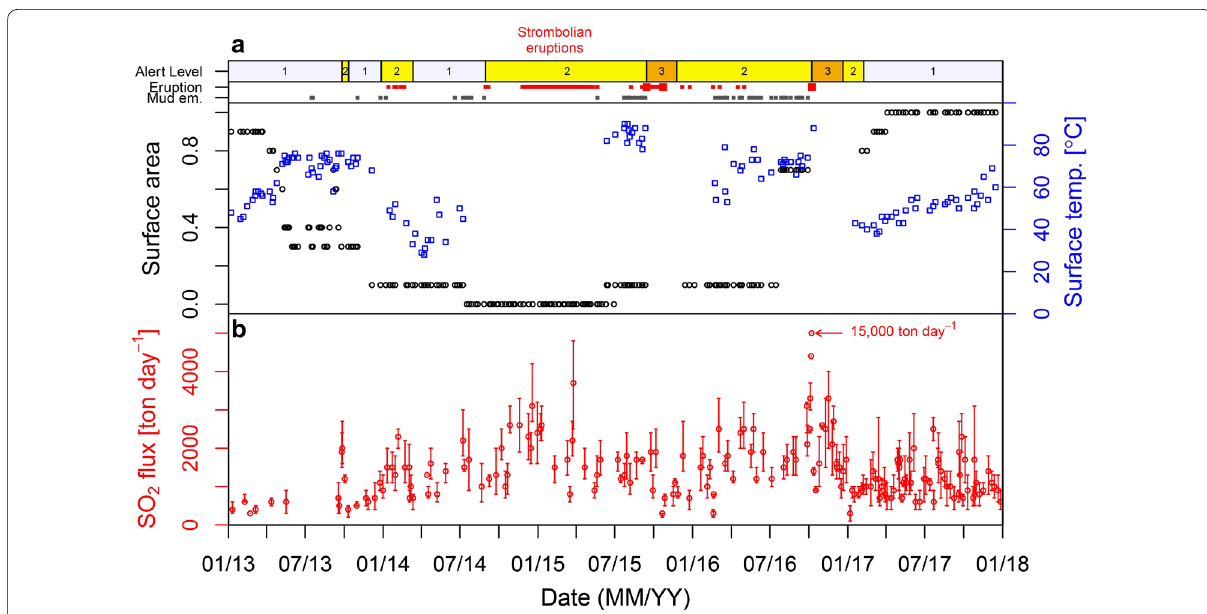
Fig. 2 Time series of a the surface area (black circle) and surface temperature (blue square) of the crater lake and b plume SO 2 flux. The surface area of the crater lake is indicated by the ratio of the area to the crater bottom. The value of 0 in the surface area corresponds to the situation where the crater lake does not exist. The value of 0.1 in the surface area includes the situation where although the crater lake exists, the amount of water cannot be estimated because the crater is mostly covered by the volcanic plume. At the upper part of a , volcanic alert levels issued by the Japan Meteorological Agency (JMA) are presented with a corresponding color code, and the dates of occurrence of eruptions and quite minor mud emissions from the crater bottom are depicted with red and gray dots, respectively. The enlarged dots of eruptions correspond to the phreatomagmatic eruptions on 14 September 2015, 23 October 2015, and 8 October 2016. The text “Strombolian eruptions” corresponds to the period when magmatic eruptions were observed (i.e., intermittent ash emissions and Strombolian eruptions). The data are from monthly reports by the JMA (available at http://www.data.jma.go.jp/svd/vois/data/tokyo /STOCK /month ly_v‑act_doc/month ly_vact_vol.php?id =